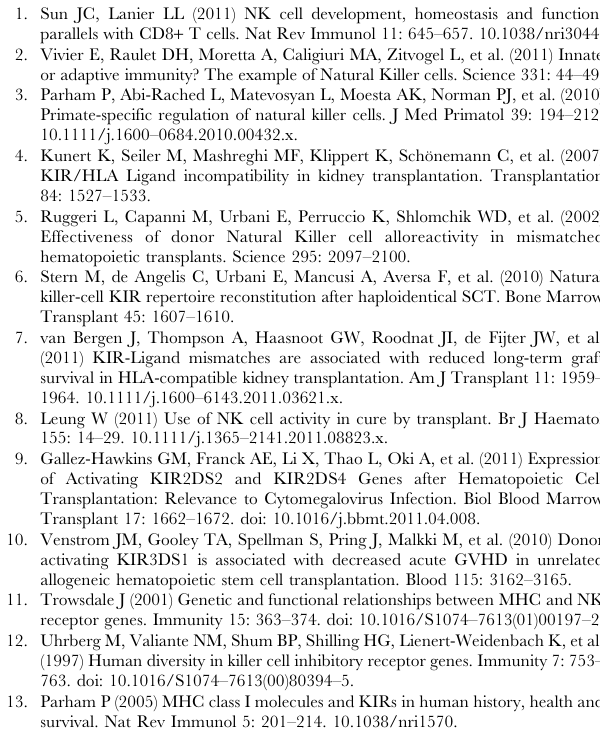
Table S4 Copy number determination by KIR MLPA technique. Table S5 A sequence alignment of the short tandem repeat region in intron 4 of most KIRs. Table S6 KIR gene copy number distribution in a cohort of healthy